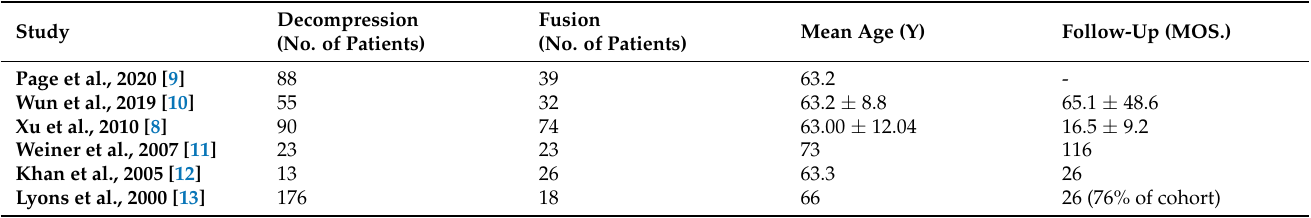
Table 1. 1 Summary of the studies comparing posterior lumbar decompression with lumbar de- compression and fixation for the treatment of lumbar synovial cysts included in the meta-analysis. (Y = years; MOS = months after surgery).